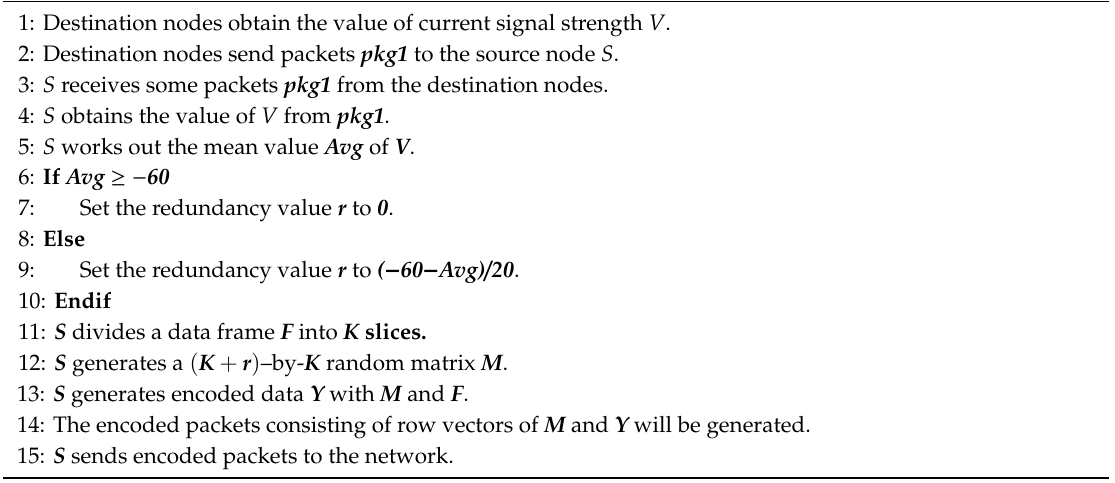
Algorithm 1 Encoding strategy at the source